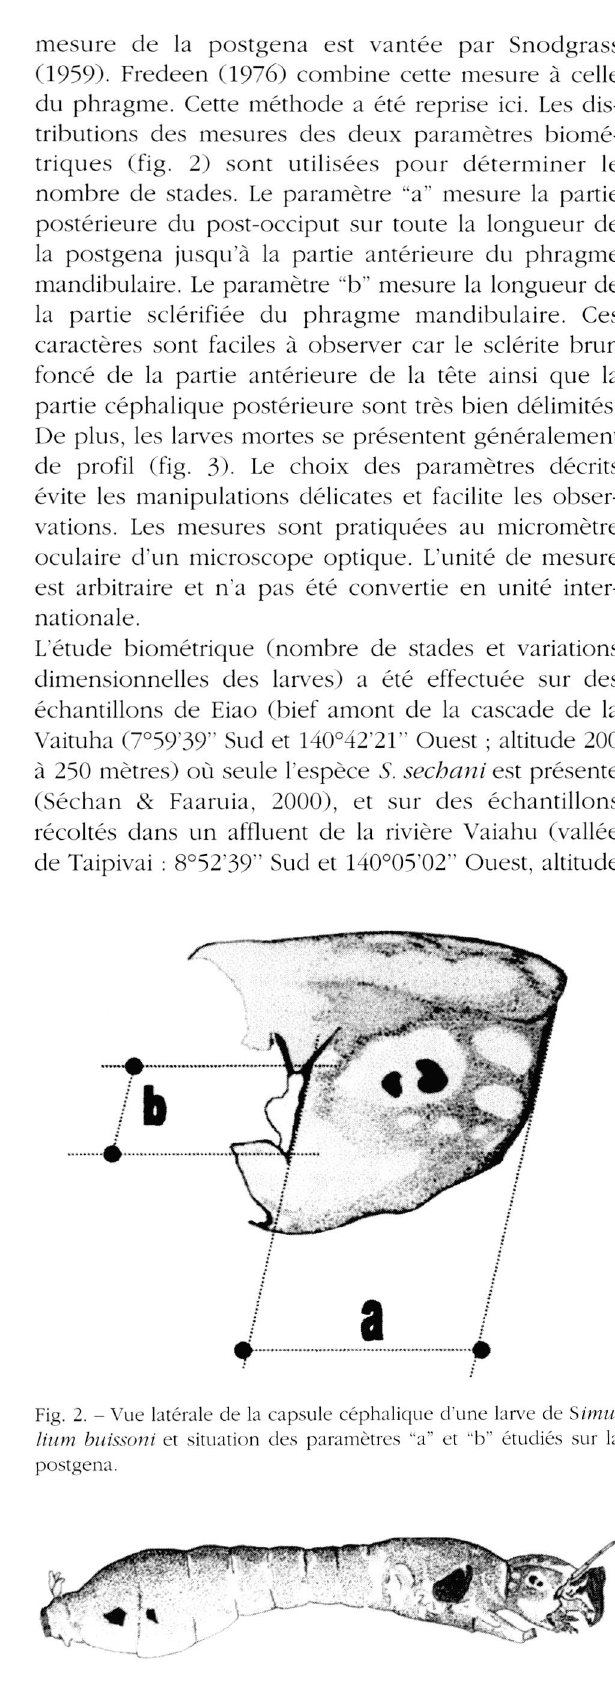
Fig. 2. - Vue latérale de la capsule céphalique d'une larve de Simu- lium buissoni et situation des paramètres "a" et "b" étudiés sur la postgena.